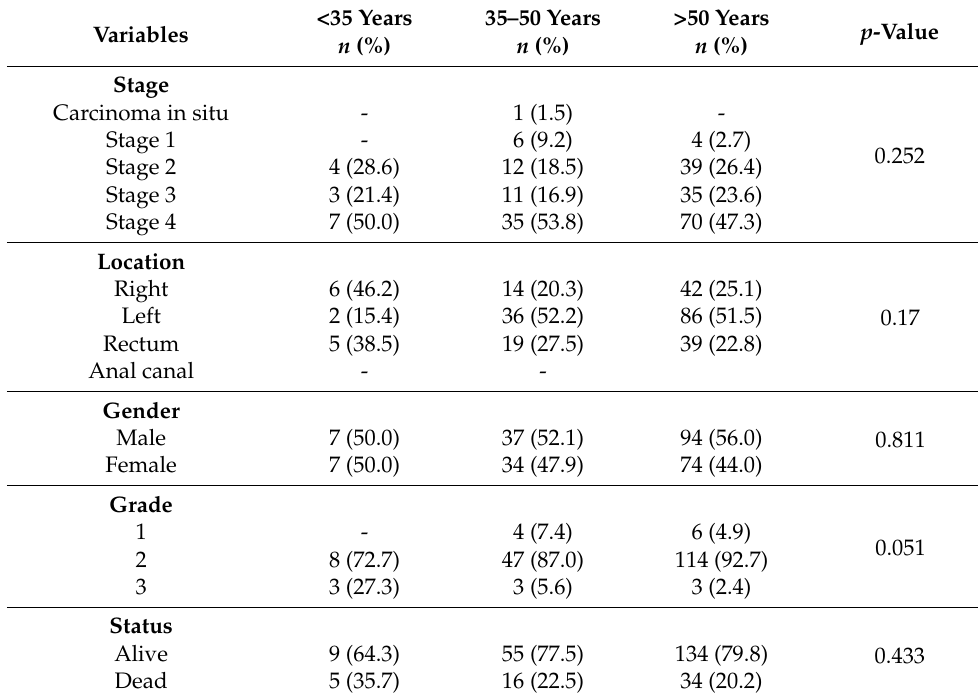
Table 7. Clinicopathological comparison between CRC